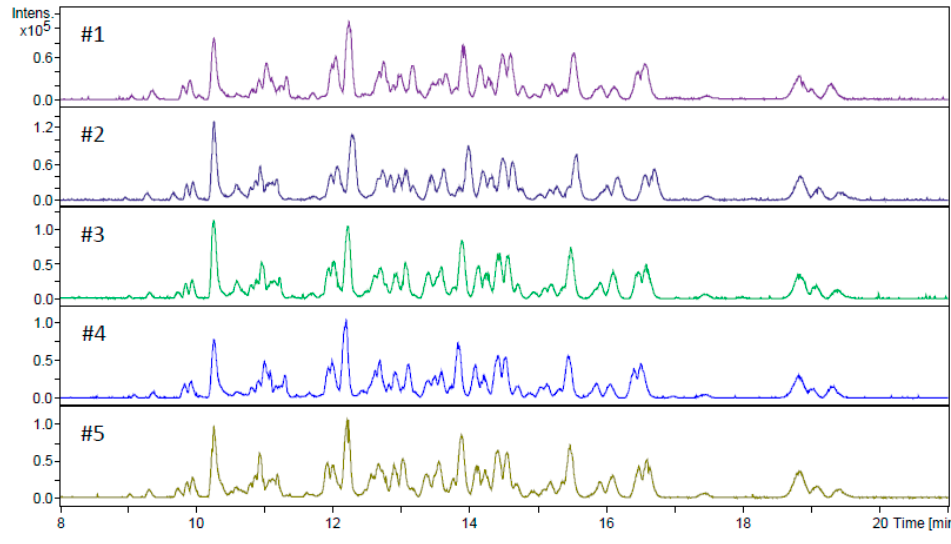
Figure 4. 5 repetitions of CZE-MS measurements after in-line digestion of human serum albumin. Conditions were the same as in Figure 3; contact time: 7.5 min. Preconditioning and injection parameters are in Table S3.